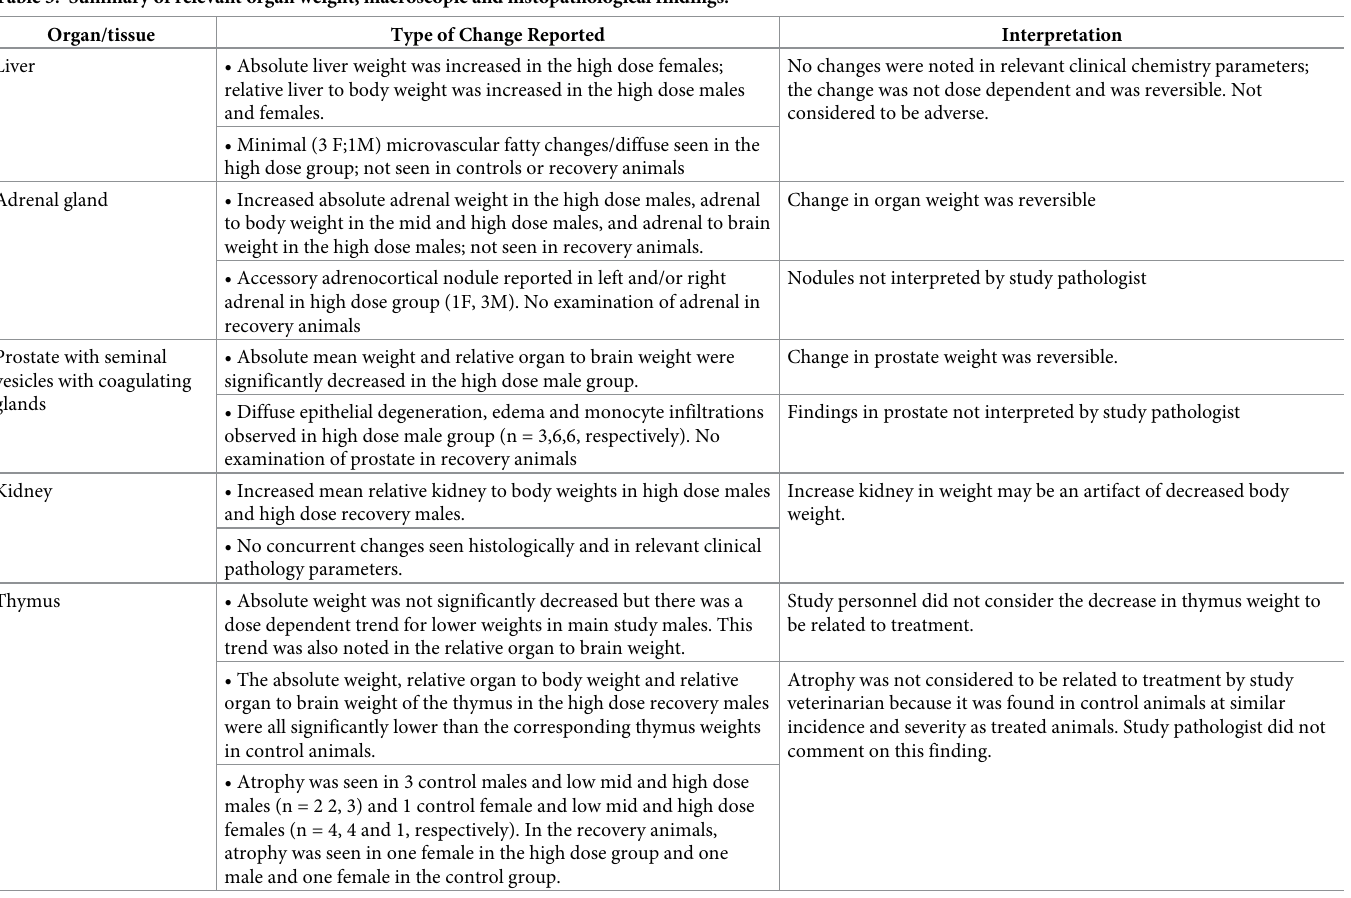
Table 5. Summary of relevant organ weight, macroscopic and histopathological findings.